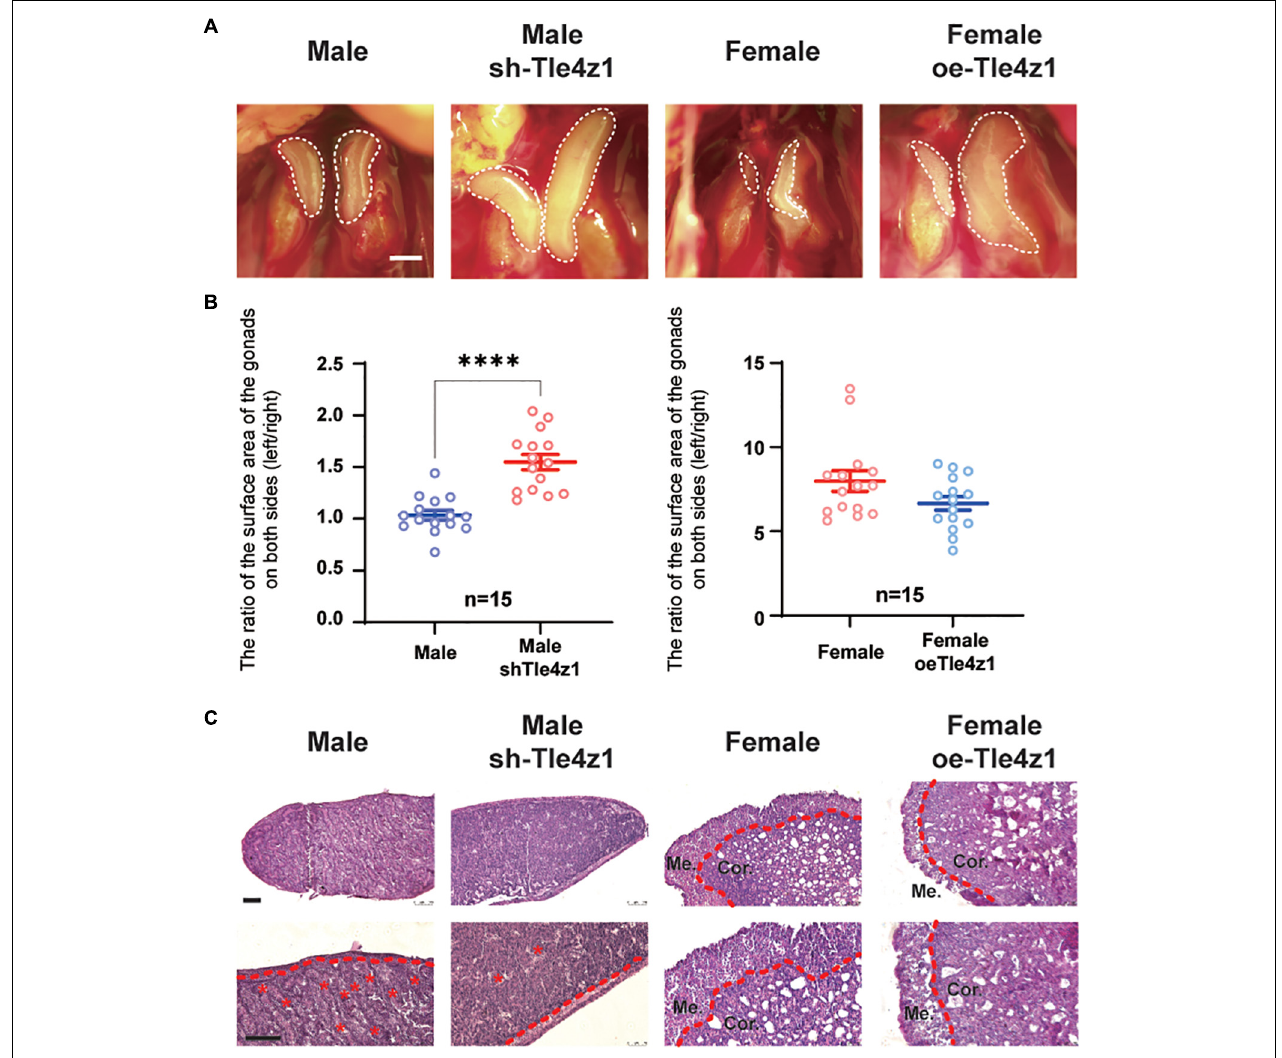
FIGURE 3 | Tle4z1 promotes the differentiation of chicken embryo gonadal phenotype to male. (A) Phenotypic differentiation of gonadal morphology at E18.5. Left two pictures are the comparison of the morphological development difference of chicken embryo testis between control and interference group. Right two are ovarian morphology of the control and overexpression group. Scale bars = 2 mm. (B) Statistical analysis of the asymmetric development of the gonads on both sides of chicken embryos. The X-axis represents the group, and the Y-axis represents the ratio of the surface area of the gonads on both sides of the chicken embryo (left/right). ∗∗∗∗ P < 0.0001, values are means ± SEM. n = 15. (C) Photomicrographs of hematoxylin/eosin (H/E) staining of gonads cultured at E18.5. The dashed red line indicates the border between the medulla and cortex. Cor.: cortex layer; Me.: medulla layer; ∗ tubuli seminiferi contorti; Scale bar = 100 µ